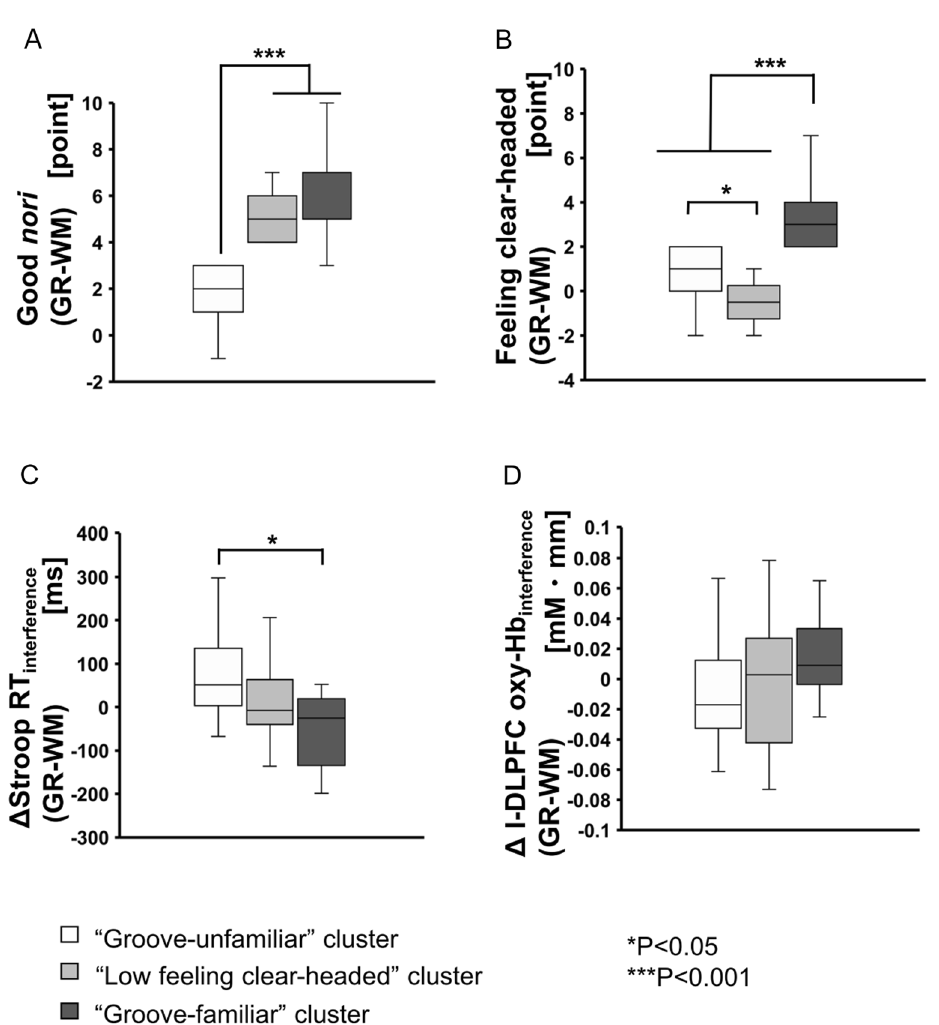
Figure 2. Comparison between clusters of “Good nori ” scores, “Feeling clear-headed” scores, ΔStroop RT interference , and Δl-DLPFC oxy-Hb interference . All variables represent condition differences (GR − WM). Values are represented as box plots where the bottom, middle, and top lines of the boxes are the 25th, 50th (median), and 75th percentiles, respectively, and the whiskers above and below each box indicate the most extreme point within 1.5 times the interquartile range. The points above or below the whiskers represent outliers. *** P < 0.001, * P <